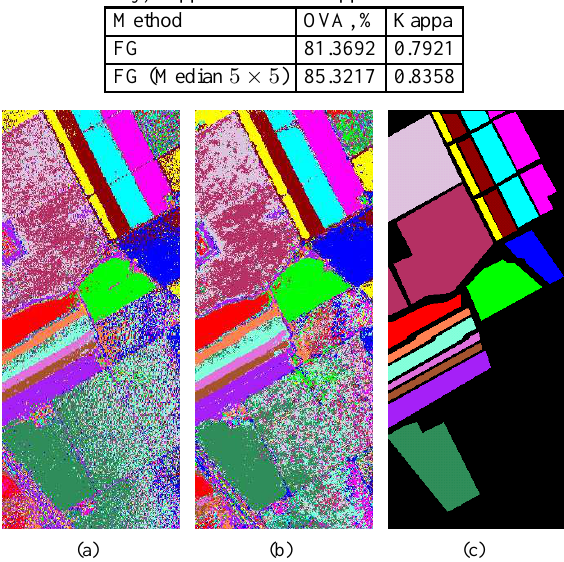
Table 2: The accuracy of salinas benchmark classification using the FG (MNF 20 features, alphabet size: 100). Additional ex- periment with feature median filtering is also presented. OVA – overall accuracy, Kappa – Cohen’s Kappa